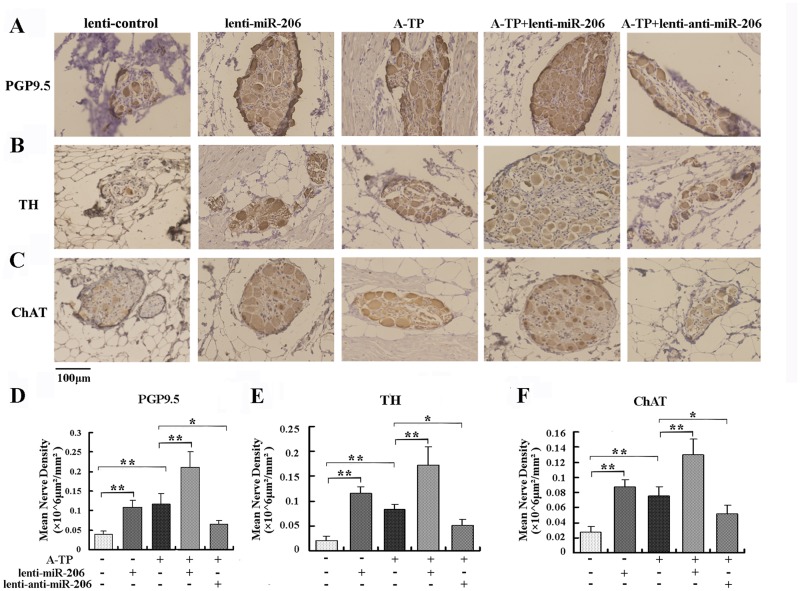
Measurement of nerve density by immunohistochemical analysis.(A) Immunohistochemical staining of PGP9.5-positive nerves in the SLGPs in the lenti-control, lenti-miR-206, A-TP, A-TP plus lenti-miR-206 and A-TP plus lenti-anti-miR-206 groups separately. (B) TH-positive nerves in five groups, as above. (C) ChAT-positive nerves in five groups, as above. (D) Histograms of mean PGP9.5-positive nerve density in the SLGPs. (E) Graphs of mean TH-positive nerve density. (F) Histograms of mean ChAT-positive nerve density. Magnification of the objective lens: 20 ×. Scale bar = 100 μm. * P < 0.05 and ** P < 0.01.